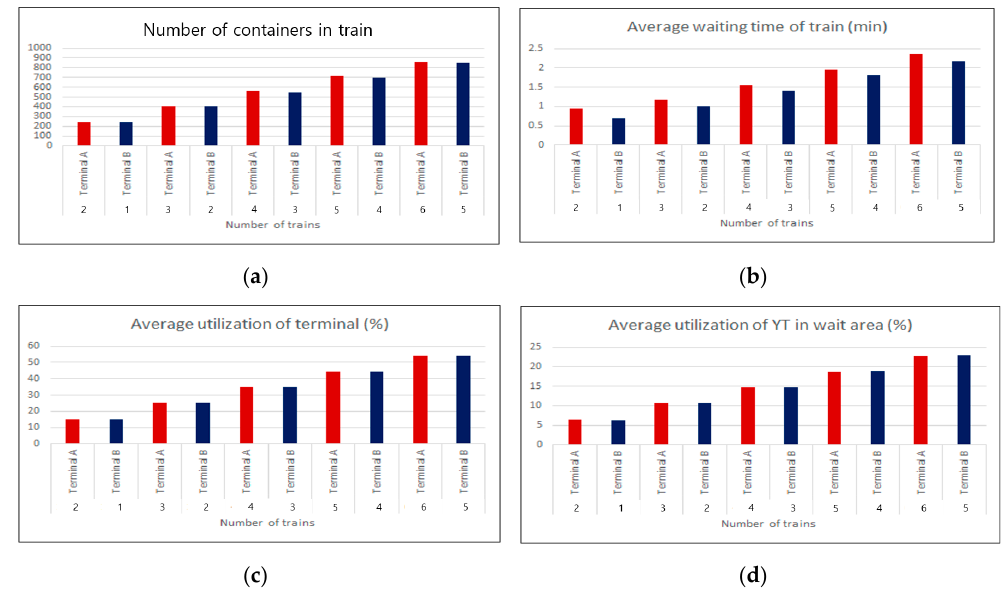
Figure 19. Simulation results for number of two-directional routes with trains, as well as the travel times between terminals A and B, with a train operating time of 18 h: ( a ) number of containers on the train; ( b ) average waiting time of the train; (c) average utilization of the terminal; ( d ) average utilization of a yard tractor in the waiting area.